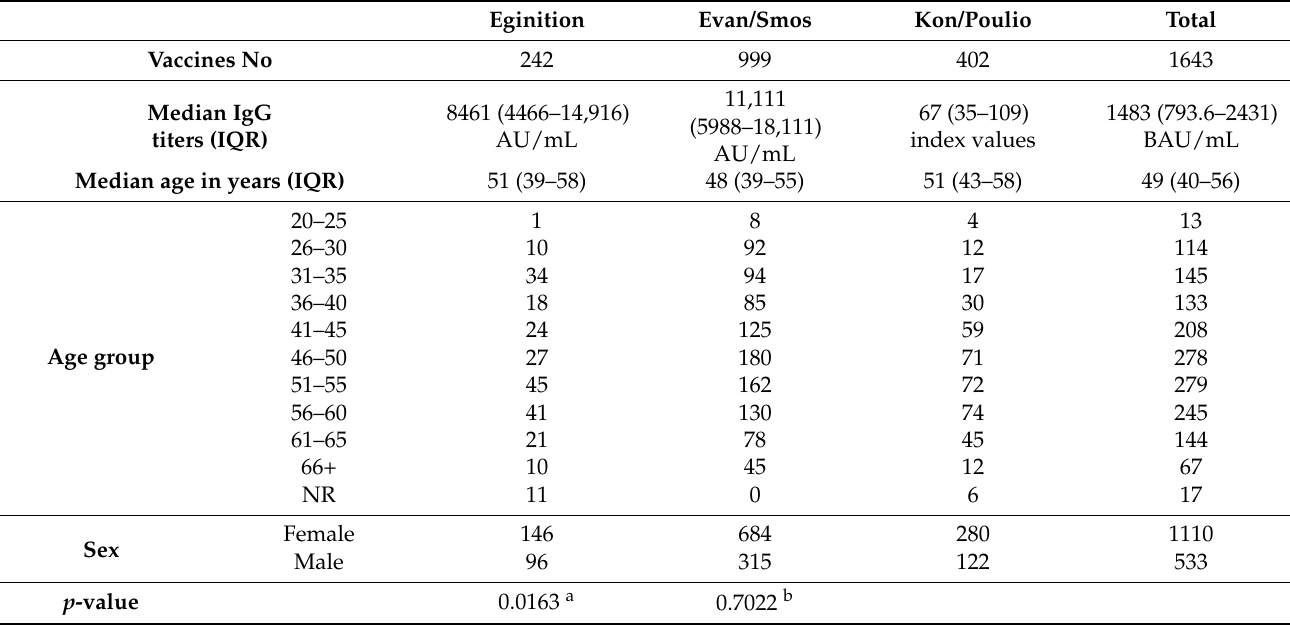
Table 1. Demographic data and anti-SARs-CoV-2 IgG titers of healthcare worker vaccinees included in the study. Eginition Evan/Smos Kon/Poulio